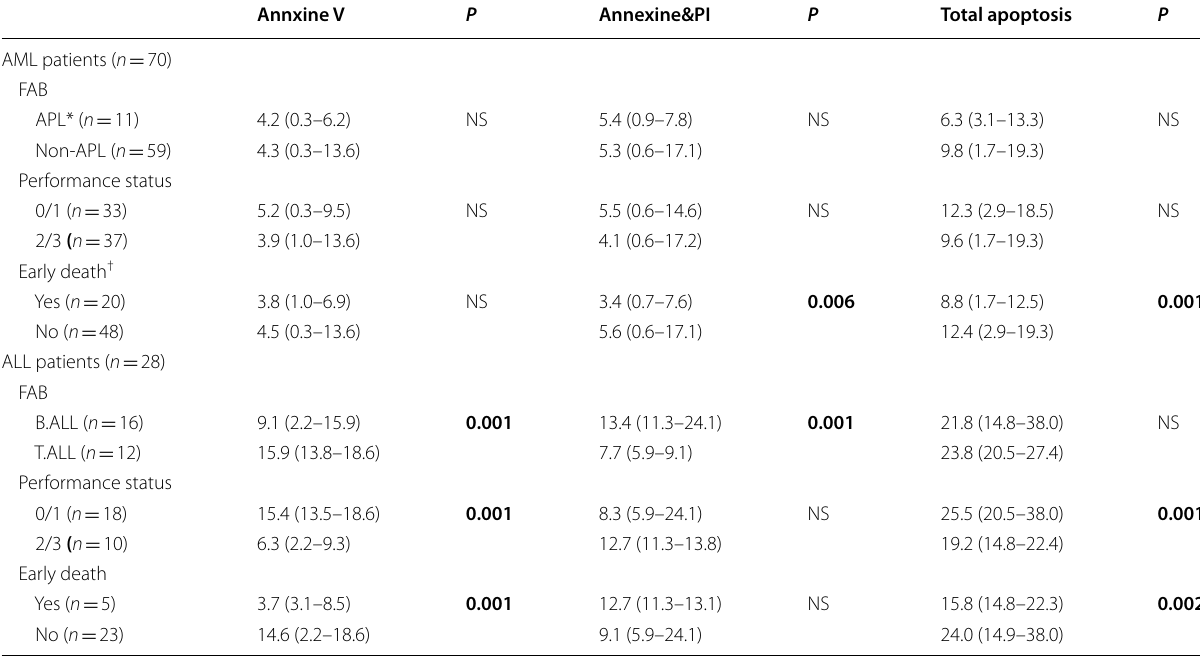
Table 2 Early, late and total apoptosis in AML and ALL patients